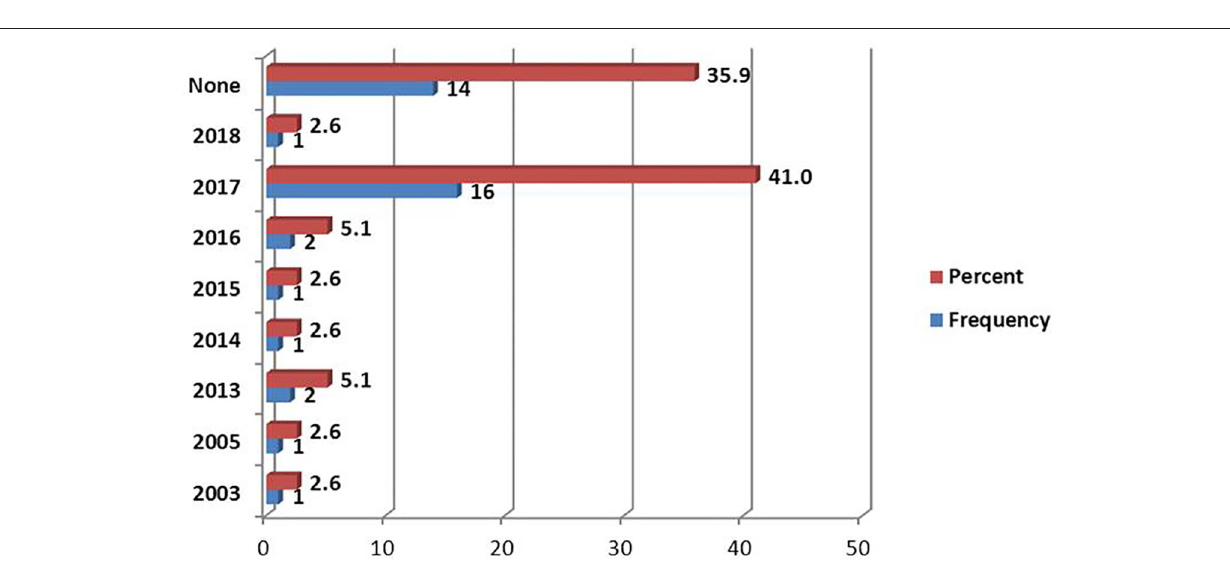
FIGURE 5 | Versions of National Essential Medicine Lists (NEMLIT) used at the health